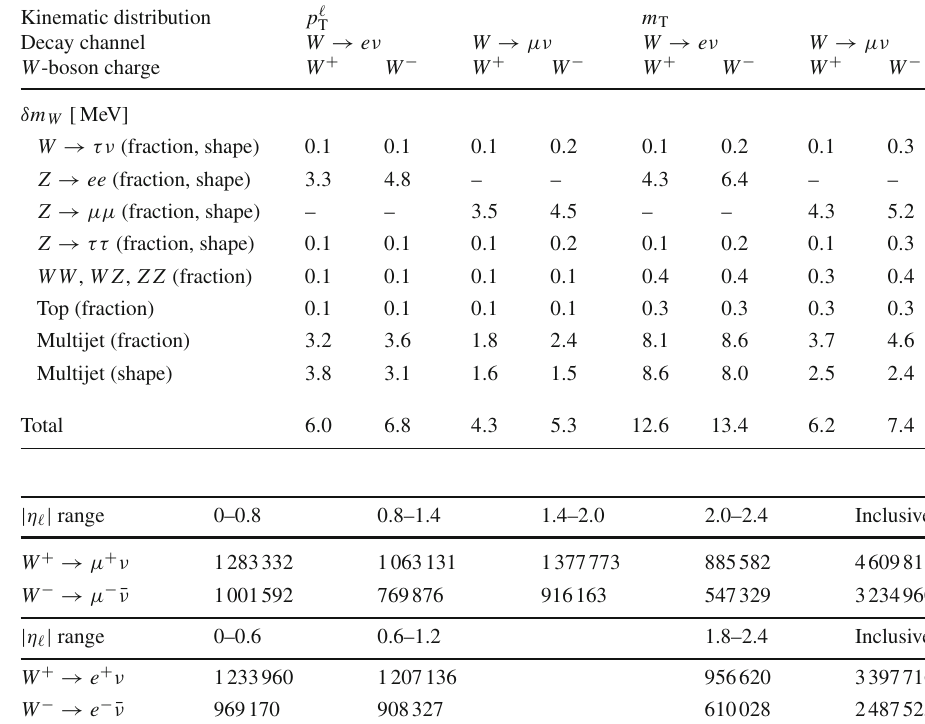
uncertainties in the m W measurement due to electroweak, top-quark, and multijet background estimation, for fits to the p (cid:7) and m T T distributions, in the electron and muon decay channels, with positively and negatively